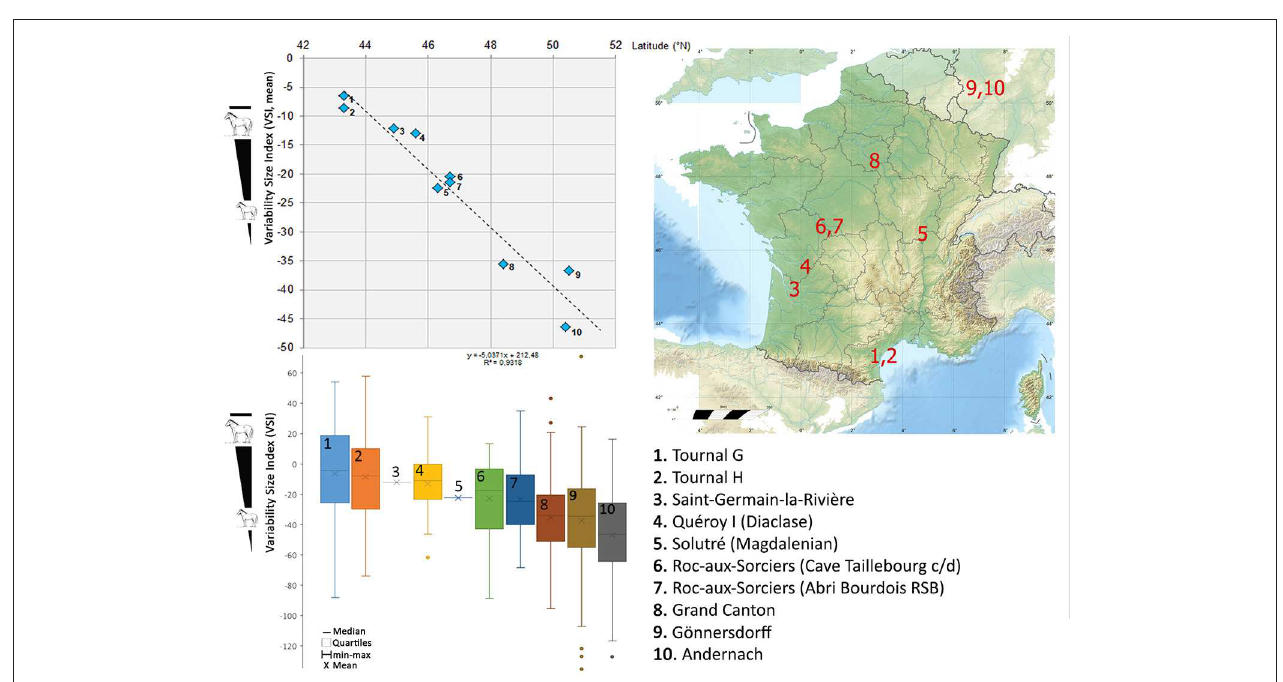
FIGURE 10 | Variability Size Index (VSI, cf. Meadow, 1999) of horse populations from the end of MIS 2 (Magdalenian). Standard: Jaurens (Mourer-Chauviré, 1980; Eisenmann, 2019). Gönnersdorf, Andernach (Cramer, 2002); Tournal (Boulbes, pers. data); Roc-aux-Sorciers (Boulbes and Valensi, unpublished data) Saint-Germain-la-Rivière (Prat, 1968); Quéroy I, Grand Canton (Véra Eisenmann, pers. com.); Solutré Magdalenian (Guadelli, 1991).